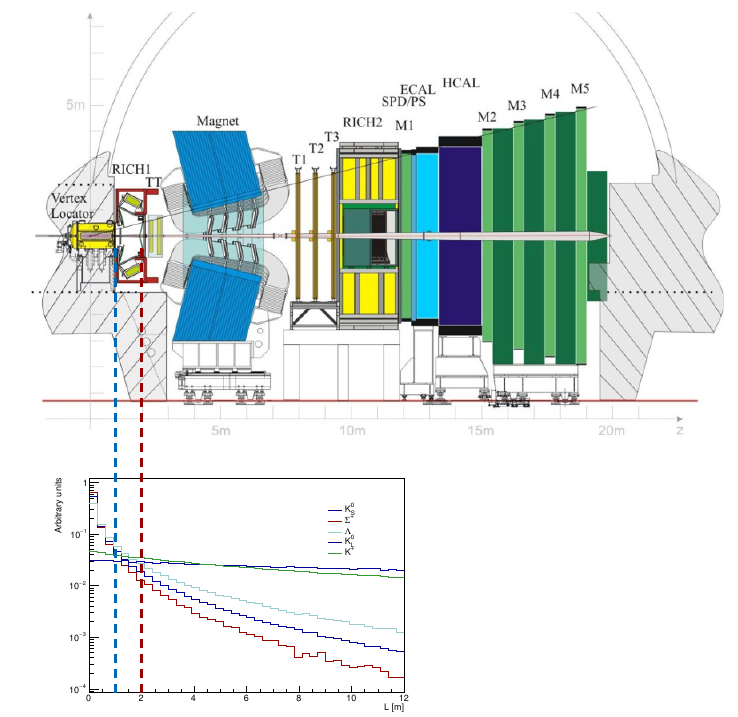
Figure 2 . A side view of the LHCb detector layout [16] compared with the decay length of strange hadrons in pp collisions at p s = 13 TeV. The blue (1m) and red (2m) dashed lines indicate the approximate distance from the interaction point at which daughter tracks can be reconstructed as long and downstream tracks, respectively.